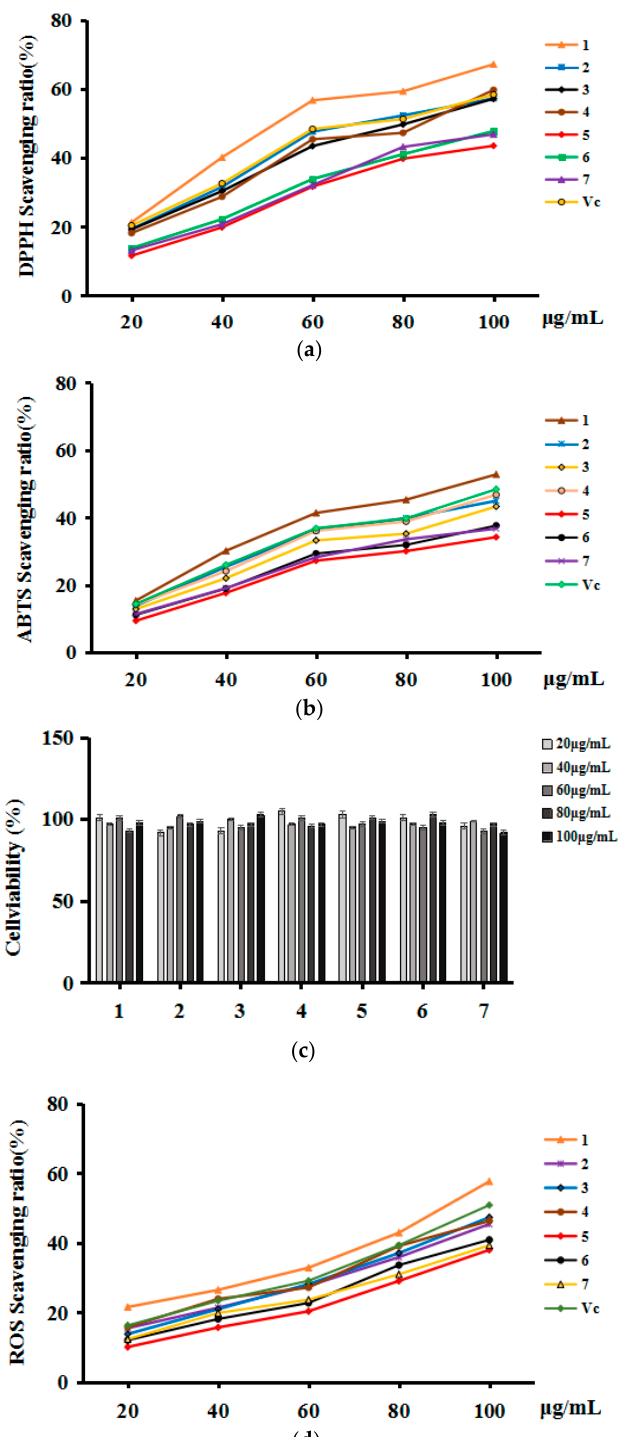
Figure 4. ( a ). Scavenging abilities of phenols from RSM fruits against the DPPH free radical. ( b ). Scavenging abilities of phenols from RSM fruits against the ABTS free radical. ( c ). Effect of phenols from RSM fruits on survival rate of HepG2 cells. ( d ). Scavenging abilities of phenols from RSM fruits against the intracellular ROS.